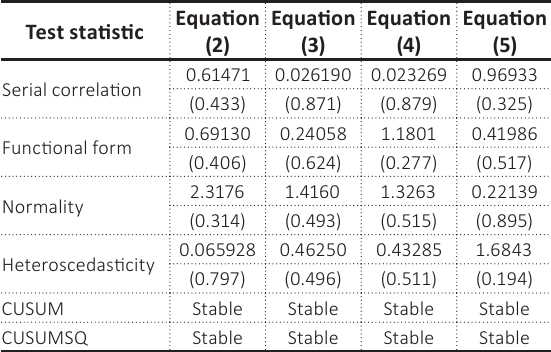
Table 7. Model diagnostics and stability